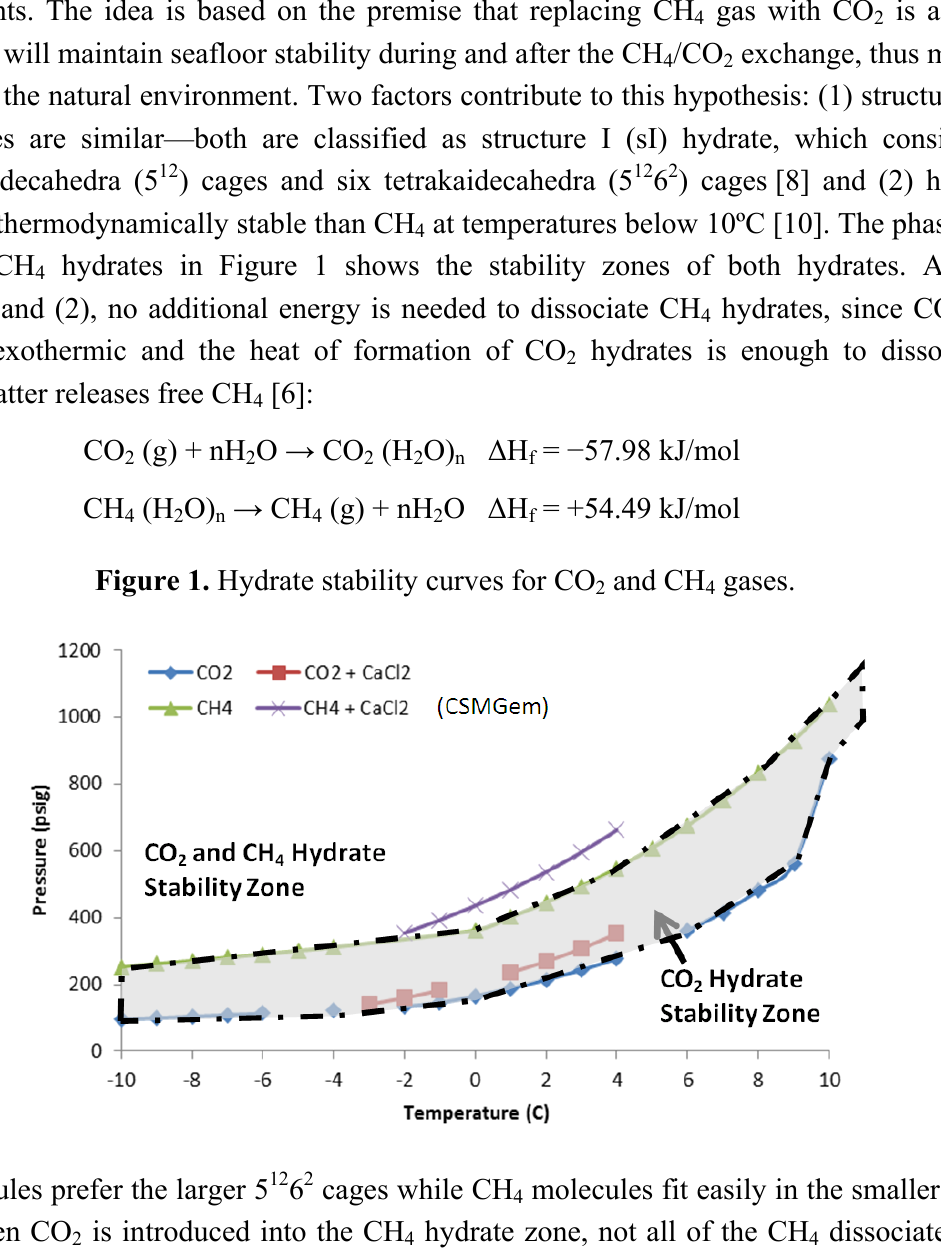
Figure 1. Hydrate stability curves for CO